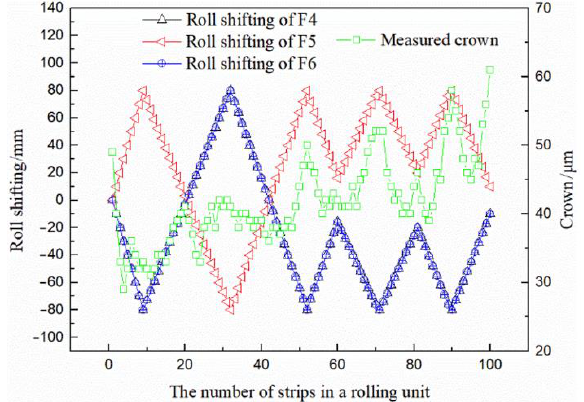
Figure 2. The measured crown in a rolling unit.